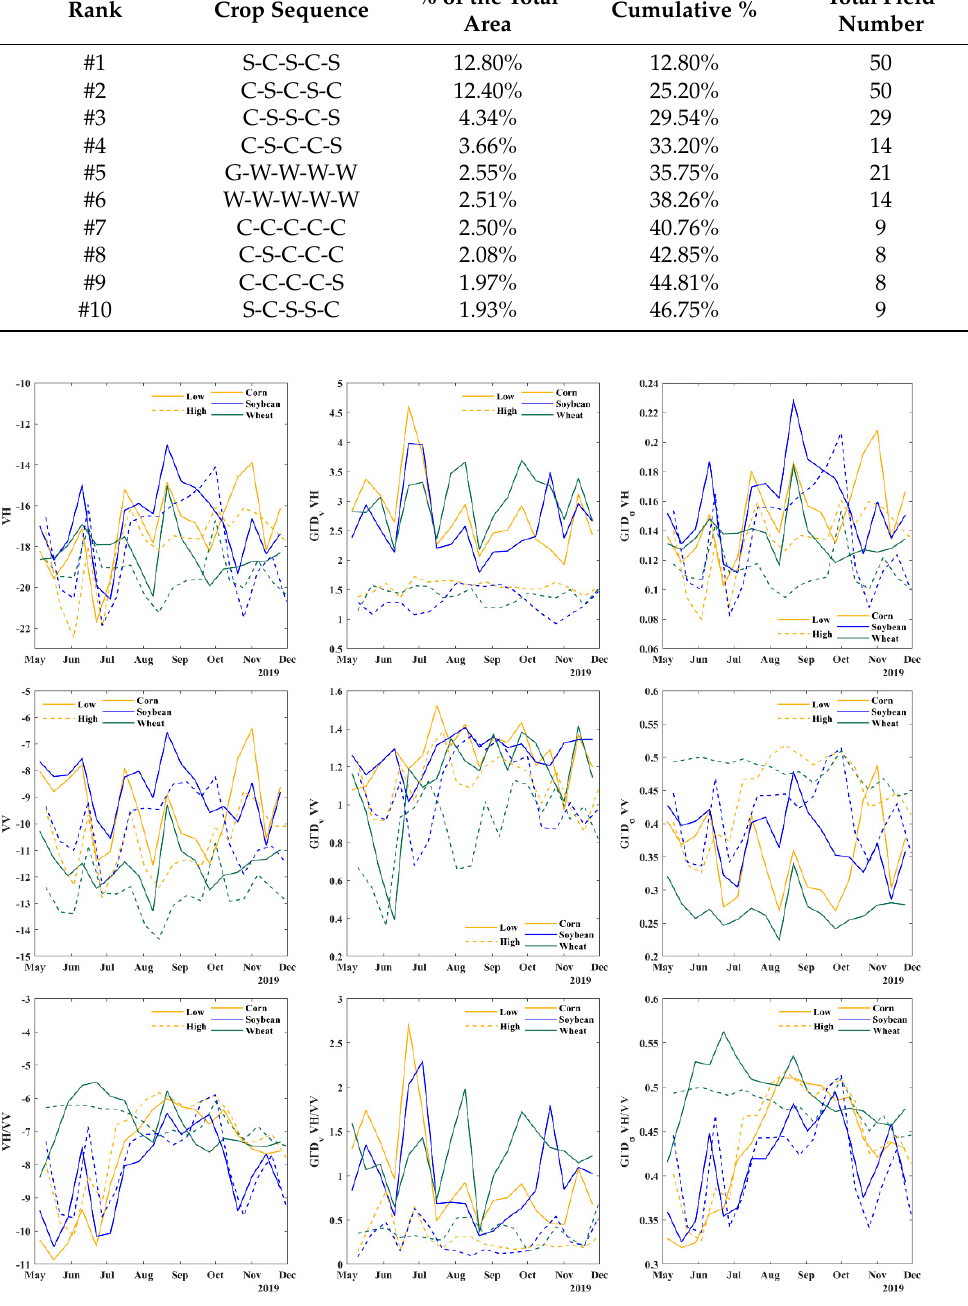
Figure 10. Feature time series for backscattering and OG Γ Ds. The solid line represents a low incidence angle and the dashed line is a high incidence angle. The yellow, blue, and green represent corn, soybean, and wheat, respectively.